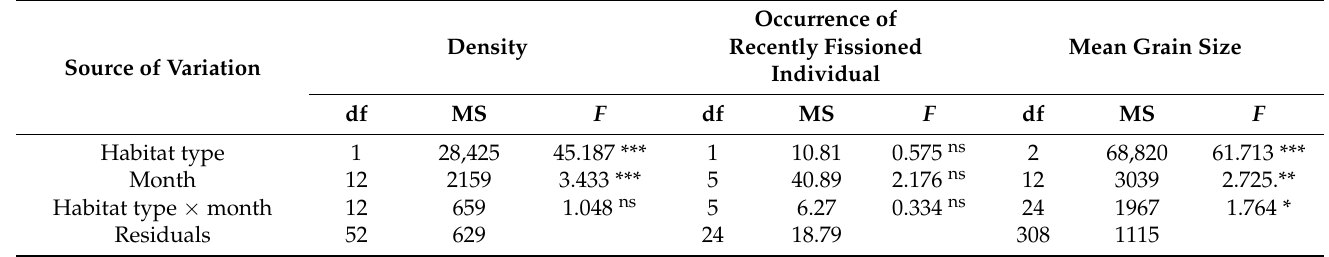
Table 2. Results of two-way ANOVA testing of data of the effects of habitat type and month on density, occurrence of recently fissioned individuals of H. atra , and mean grain